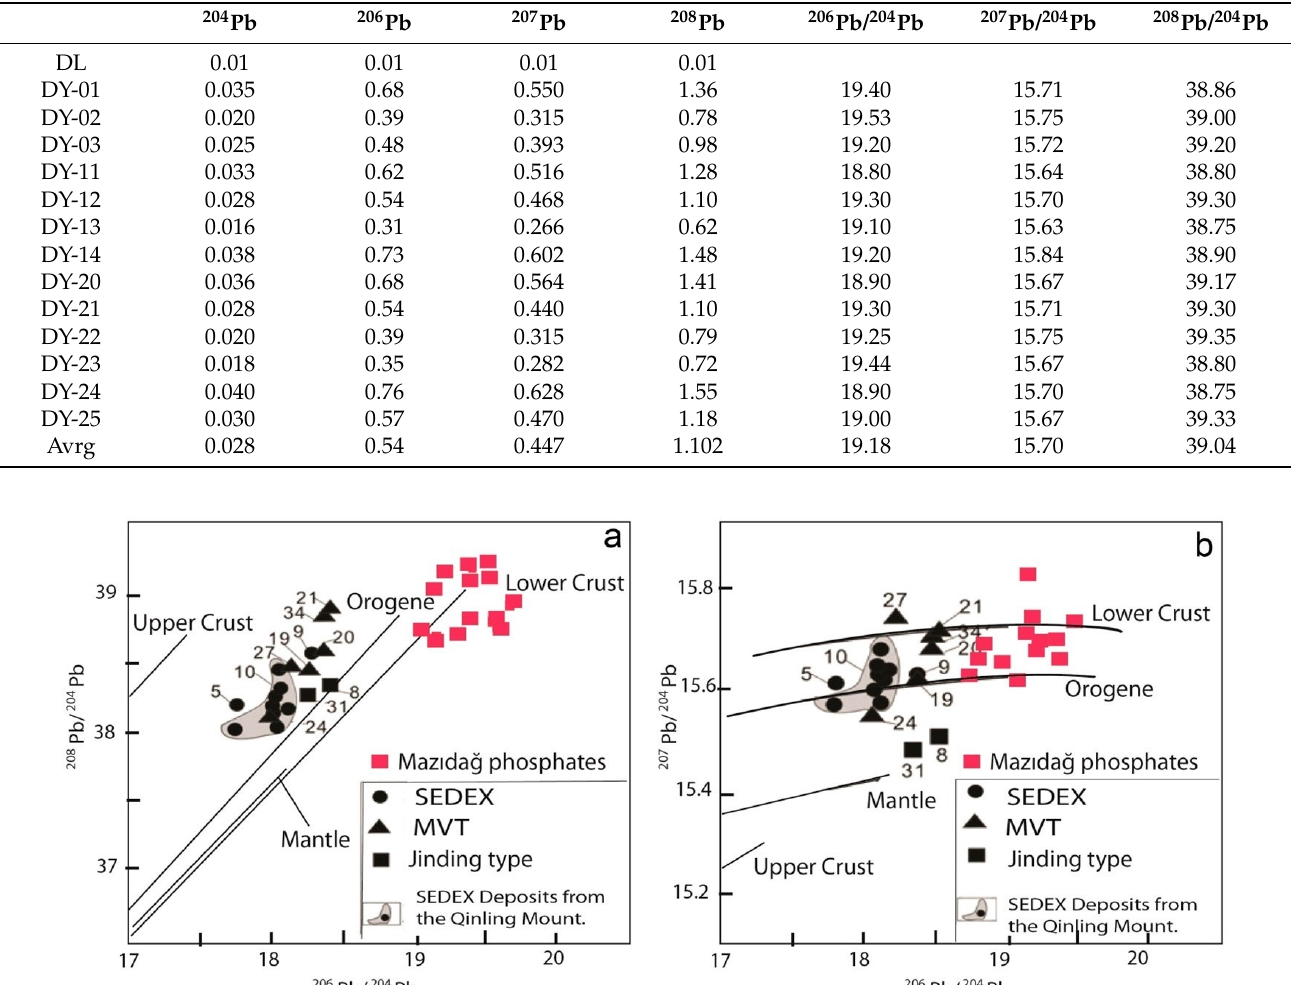
Table 6. Pb isotope ratios of the Mazıda˘gı phosphates.